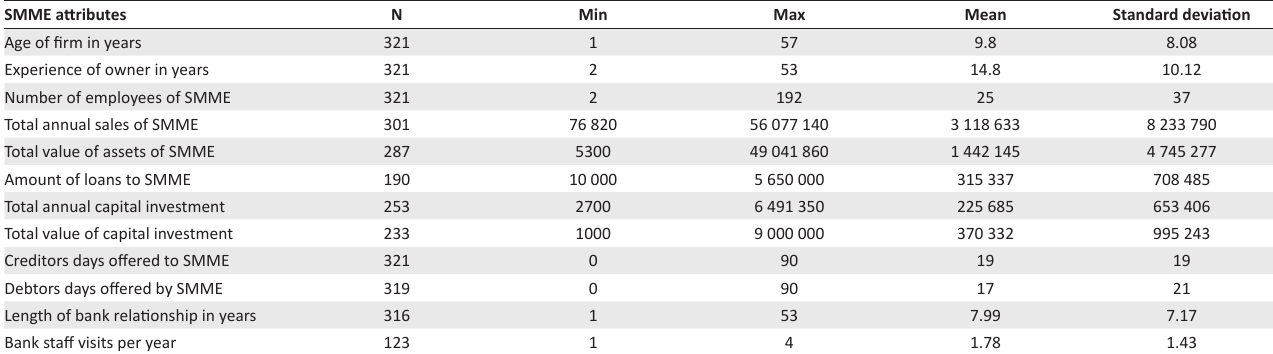
FIGURE 2: Variables analysis map. TABLE 1: Summary statistics.